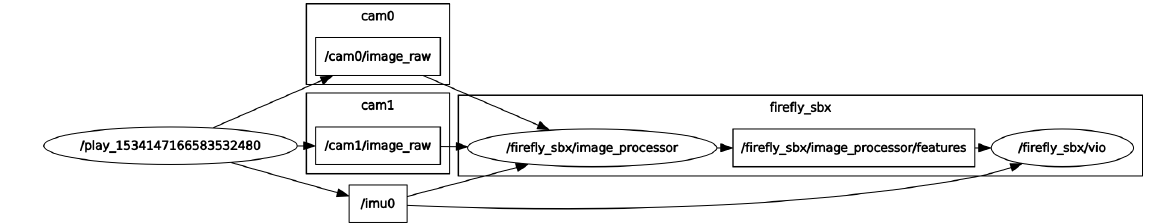
Figure 8. ROS rqt graph of the latency compensated VIO linked to the EuRoC dataset.